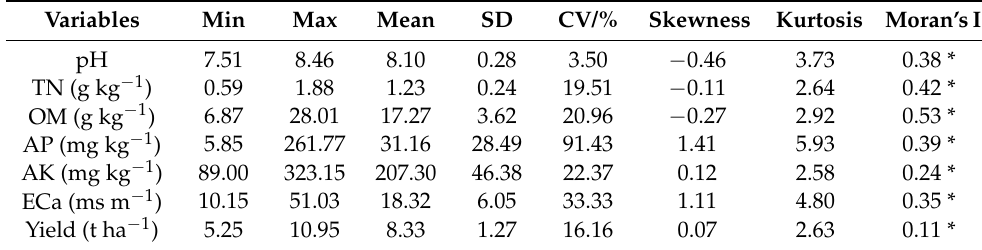
Table 1. Summary statistics of the studied